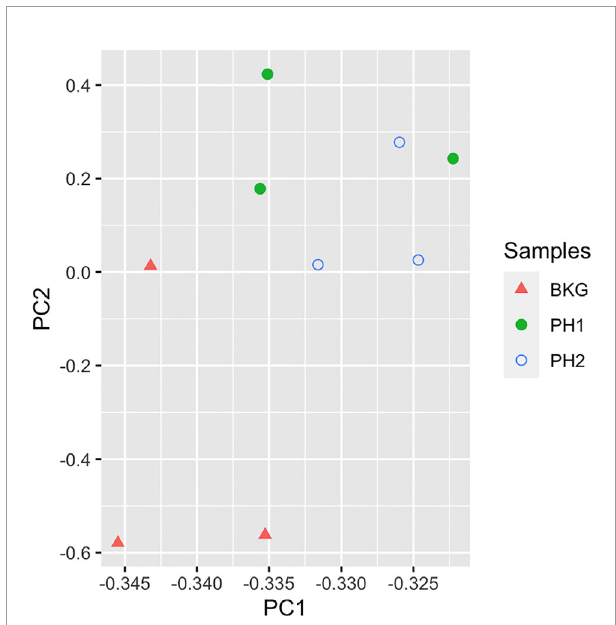
FIGURE 4 | TV sEVs cluster separately from background medium control. Principal component analysis was used to compare sEVs on the log2- transformed abundance values of all proteins identi fi ed. Triangles represent background medium (BKG), fi lled circles represent virus-negative TV phenotype (PH1), un fi lled circles represent virus-positive TV phenotype